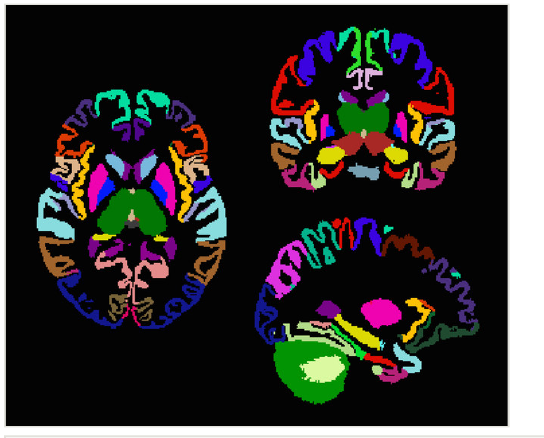
Figure 6. Example joint fusion of multiple label assignments.